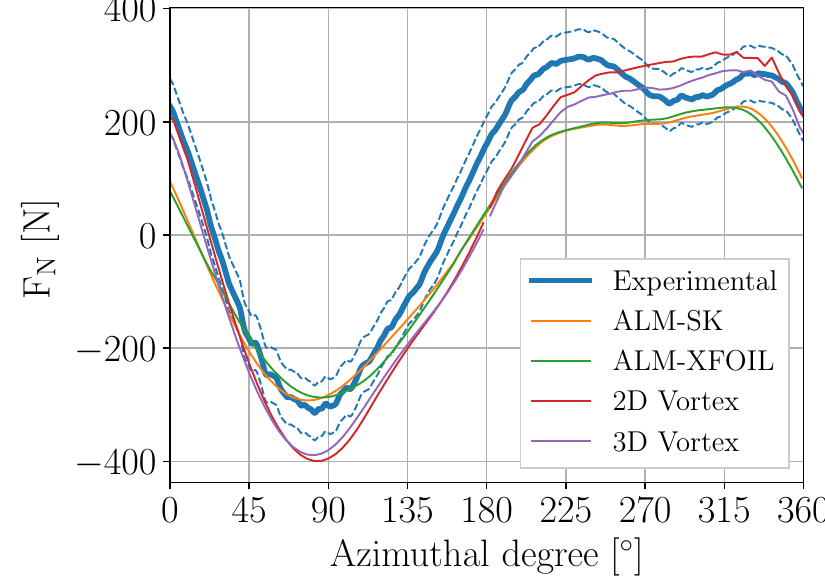
Figure 10. The normal force response at λ =